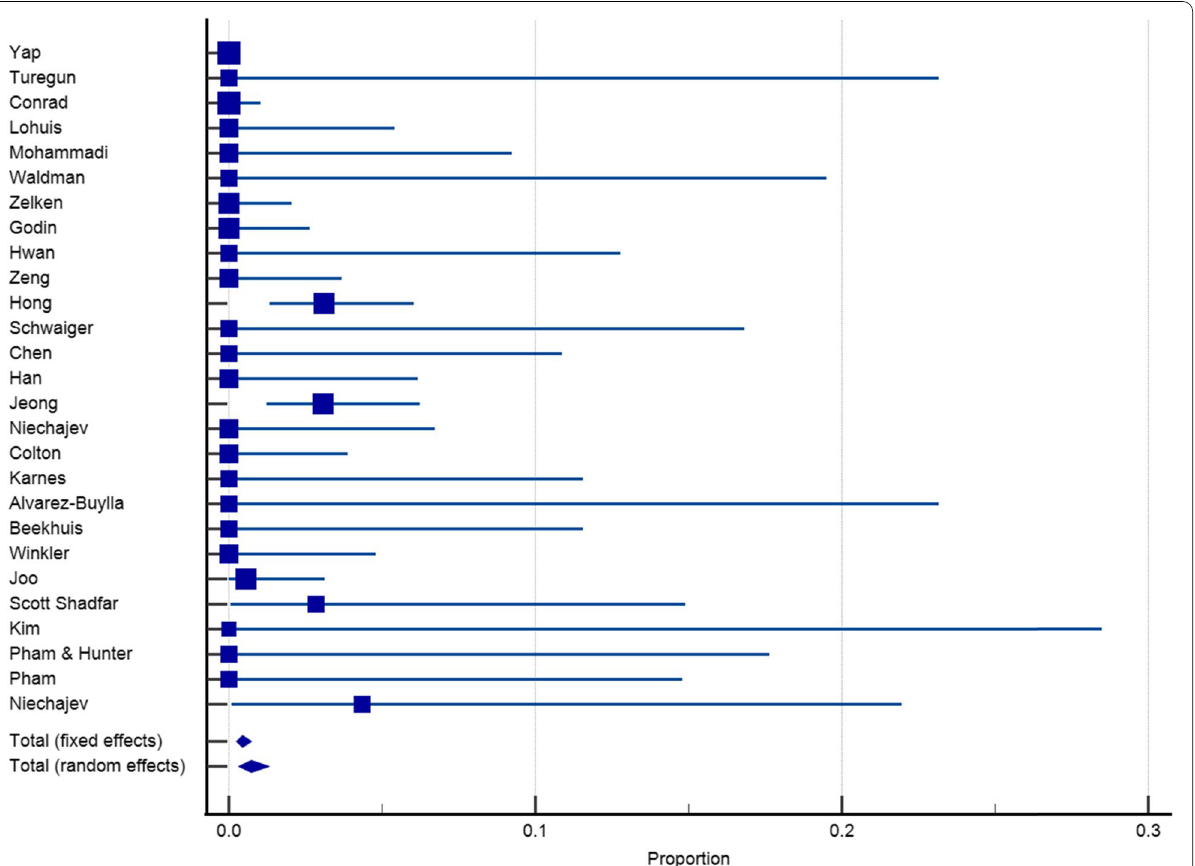
Fig. 4 Irregularity rates reported for synthetic materials in both fixed and random-effects